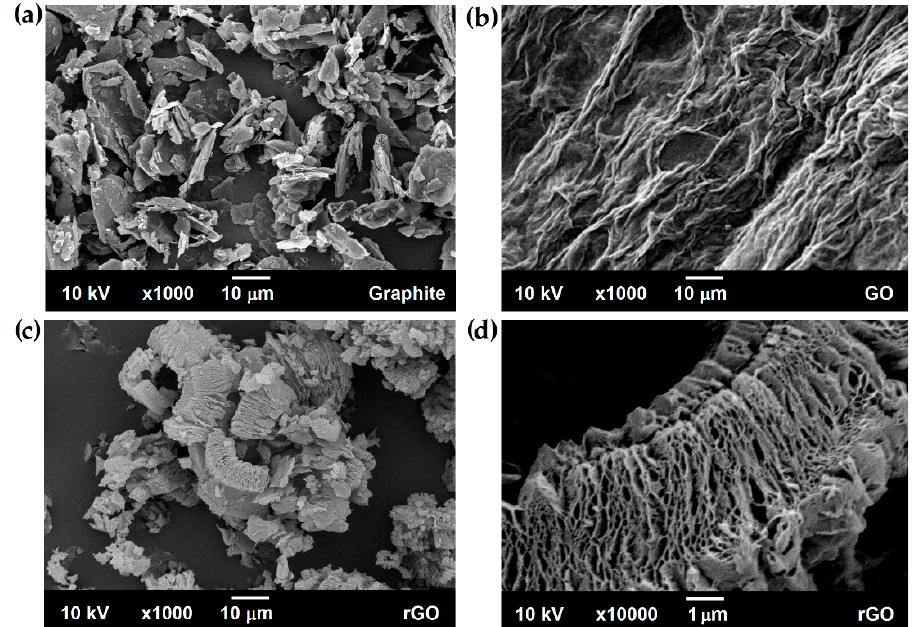
Figure 5. SEM images: ( a ) graphite; ( b ) graphene oxide; ( c , d ) reduced graphene oxide.